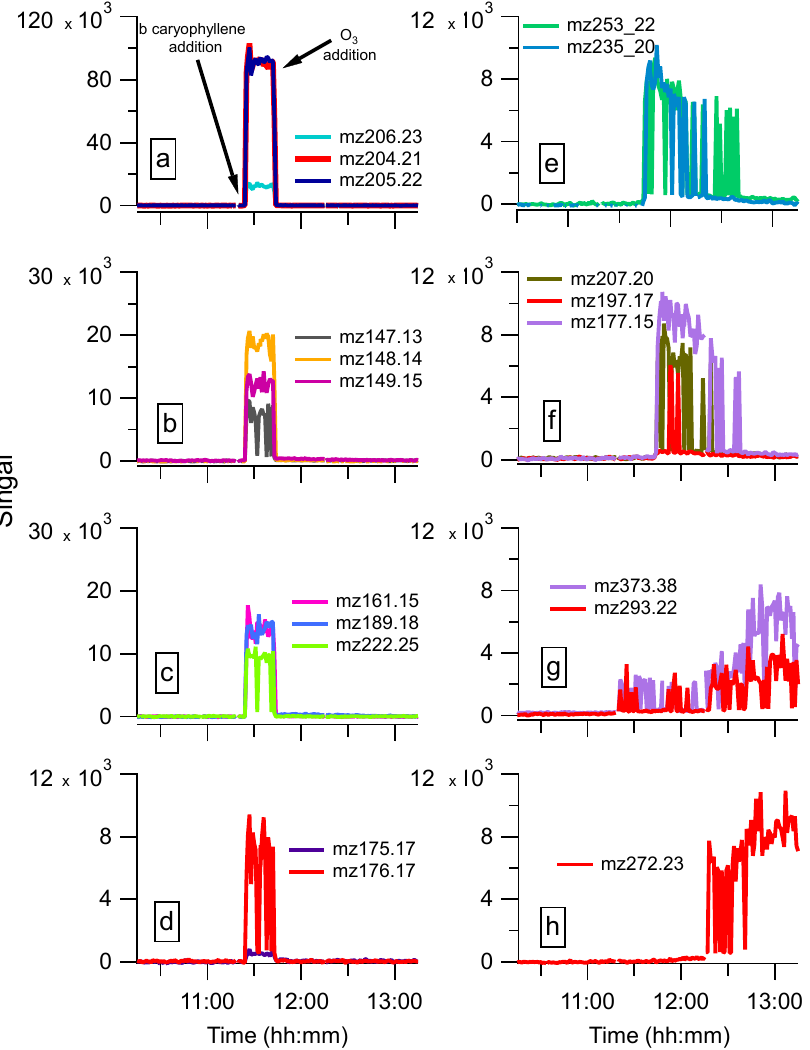
Figure 5. Results of chamber experiments of β-caryophyllene: ( a – d ) β-caryophyllene detected in several m/z values; ( e – h ) products that are detected in the gas phase.